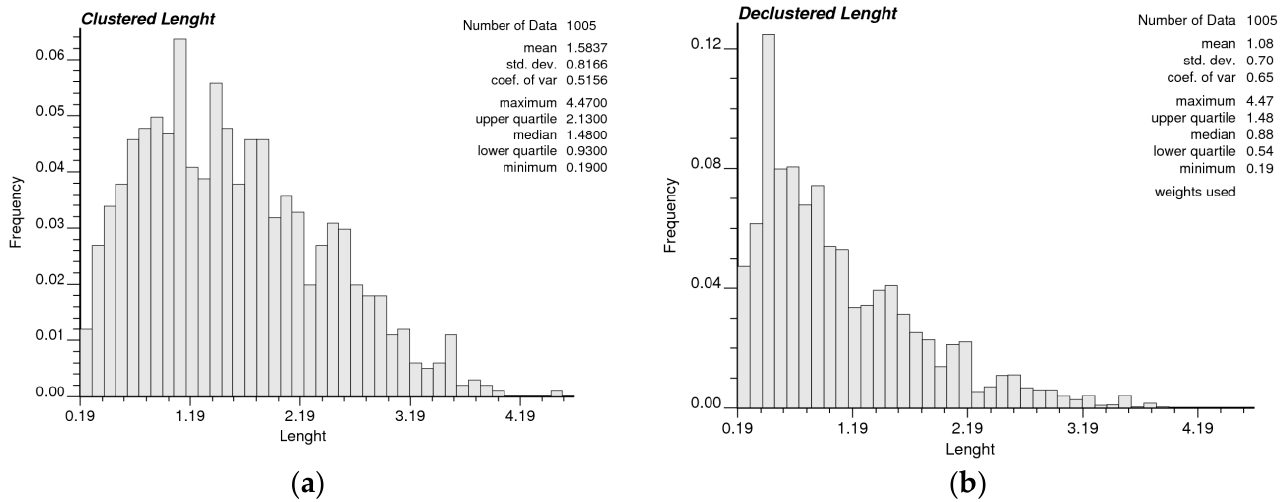
Figure 6. Distribution of thickness: ( A ) clustered data and ( B ) declustered data.